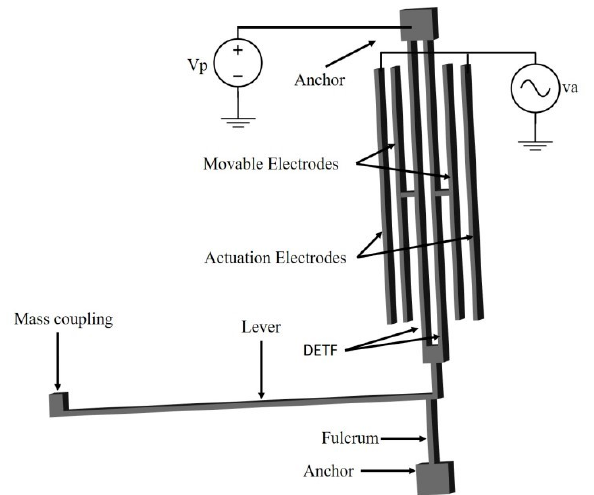
Figure 1. Schematic of a DETF coupled to a force amplification mechanism, namely a first-class lever. All the features and the electrical connections are represented.